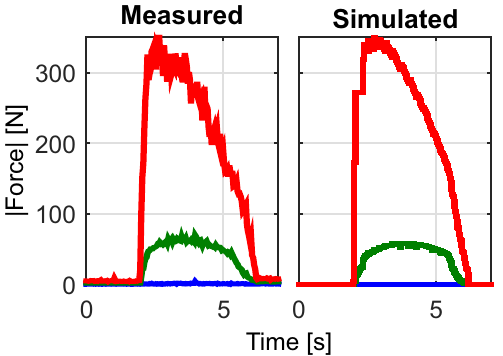
Figure 9. Comparison of the measured and the sim- ulated force signal in the case of continously varying axial and radial immersions. (cid:4) - Maximum force, (cid:4) - average force, (cid:4) - minimum